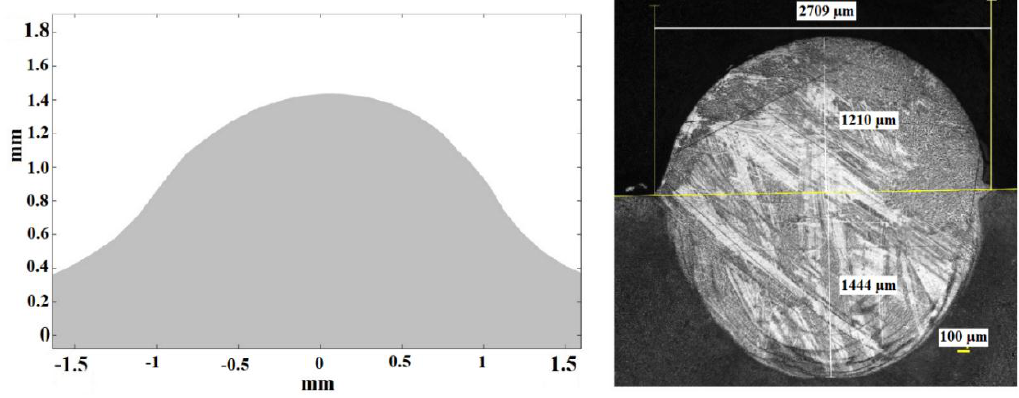
Figure 13. Theoretical ( left ) and experimental ( right ) cross sections corresponding to test 2.